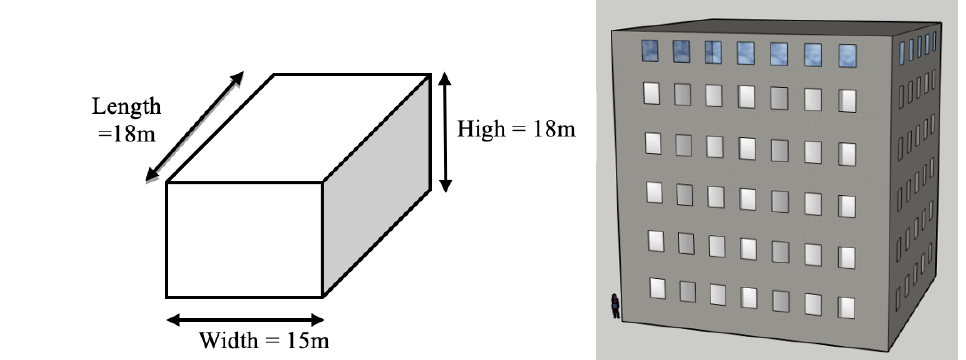
Figure 5. Illustration of the building modelized for the study.